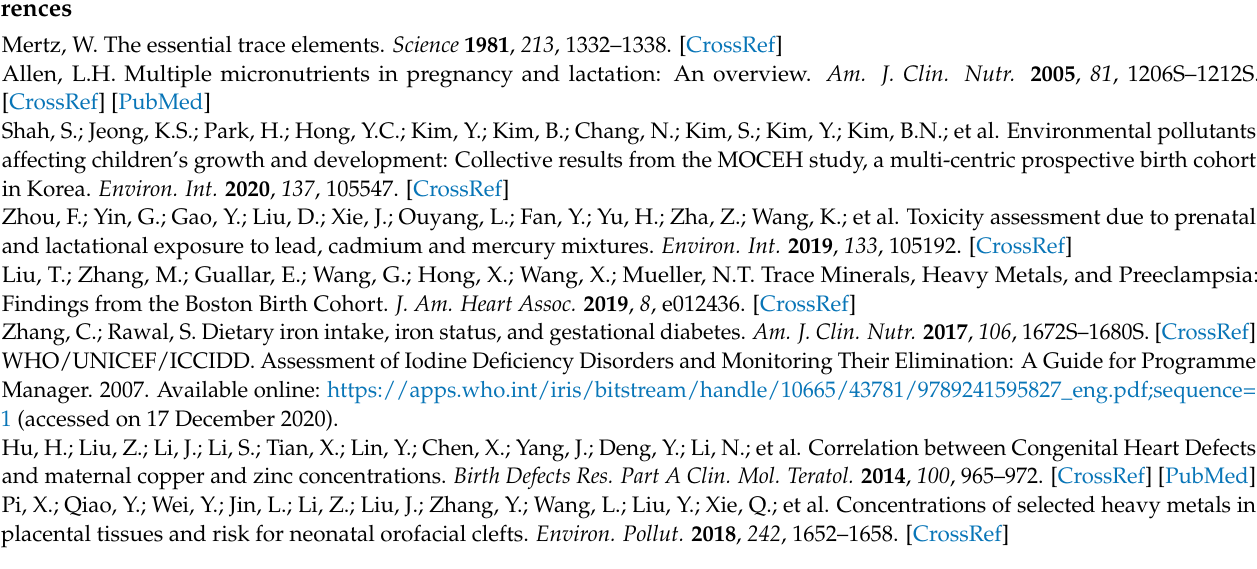
(LOD), Table S2: Dietary intakes for participants (n = 1208), Table S3: Dietary reference intakes of essential trace elements, Table S4: Quantile regression results from the adjusted models for median concentrations (ng/mL) of essential elements for pregnant and lactating women, Table S5: Quantile regression results from the adjusted models for median concentrations (ng/mL) of toxic elements for pregnant and lactating